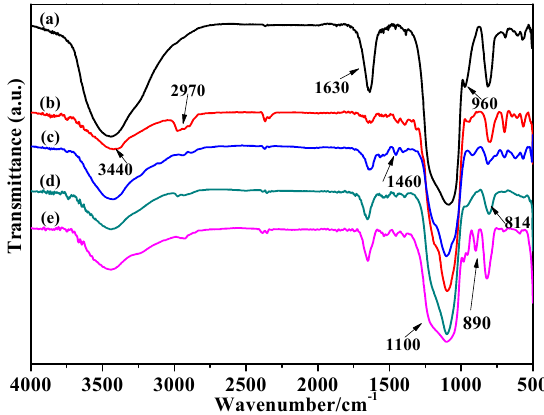
Figure 1. FT-IR spectra of ( a ) SiO 2 ; ( b ) SiO 2 -Im; ( c ) SiO 2 -Cl; ( d ) SiO 2 Im + Cl − SiO 2 ; ( e ) PW(0.058)/SiO 2 Im + Cl − SiO 2 .